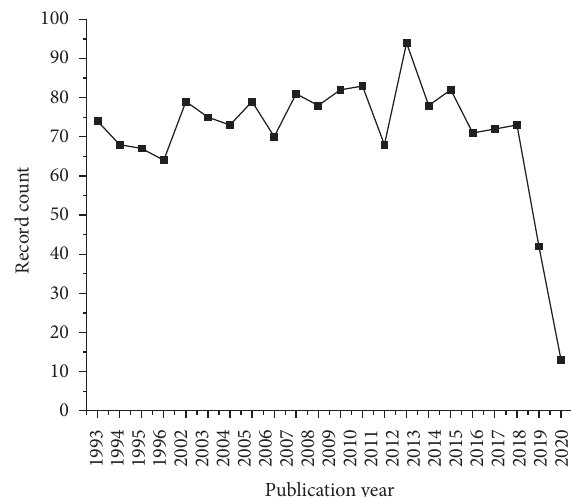
Figure 2: Patent publishing trends between years 1993 and